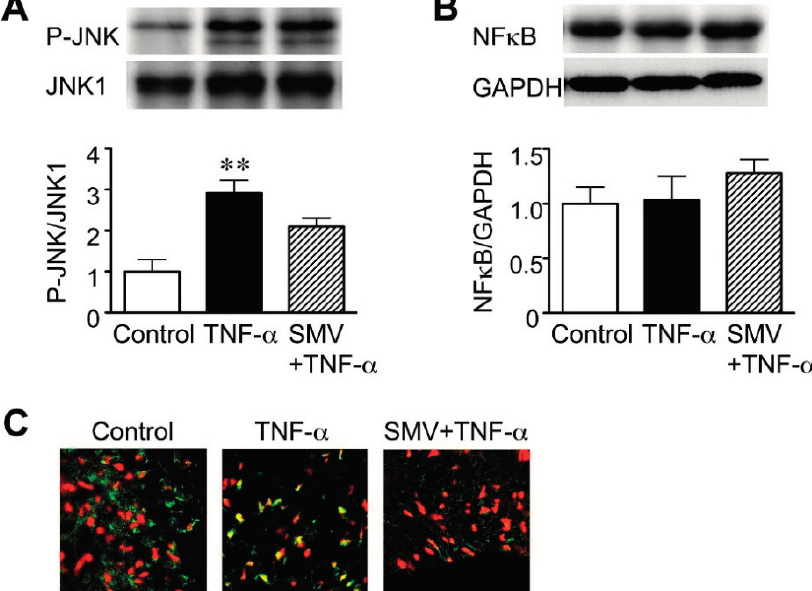
Figure 1. Effect of statins on c-Jun N -terminal kinase (JNK) and nuclear factor (NF)- κ B activation in human abdominal aortic aneurysm (AAA) wall. A human AAA wall was